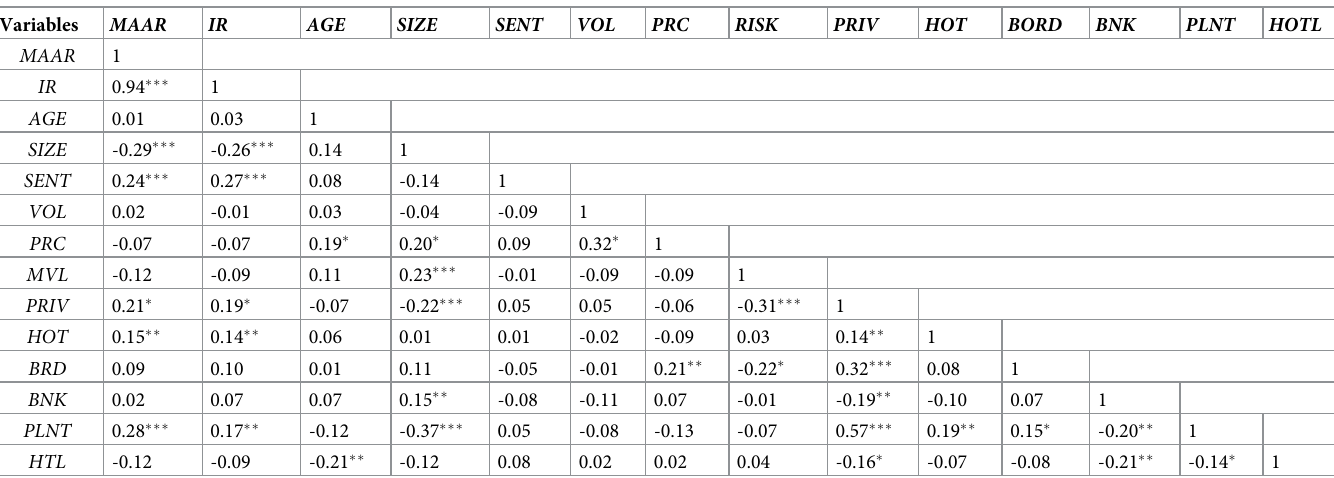
Table 8. Pearson correlation